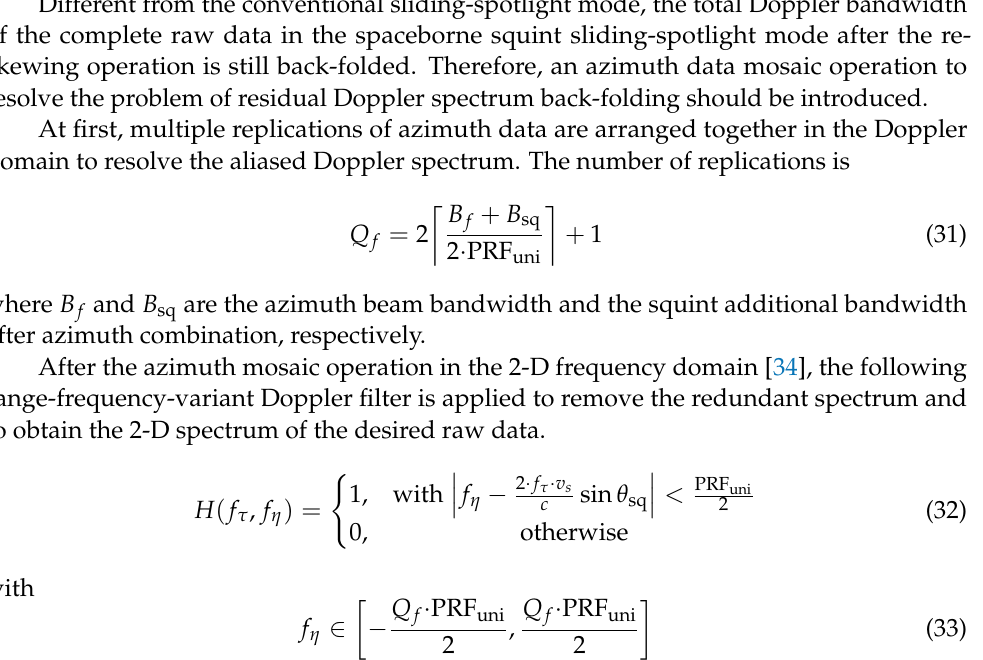
Figure 14. Azimuth time–frequency diagram after de-ramping processing. Different from the conventional sliding-spotlight mode, the total Doppler